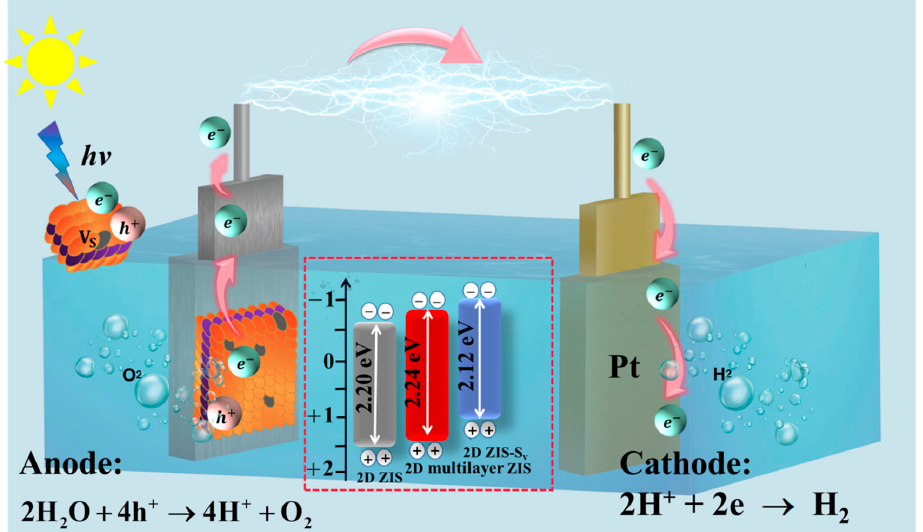
Figure 9. Mechanism illustration of photoelectrochemical water splitting of 2D ZIS-S v and the band structure of 2D ZIS, 2D ZIS-S v, and multilayer 2D ZIS.